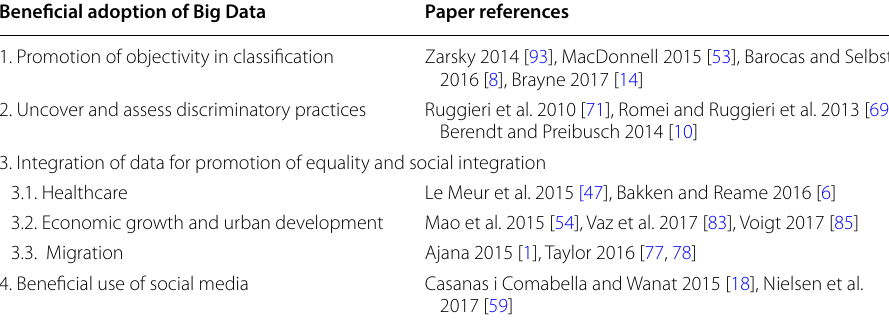
Table 7 Beneficial adoption of data analytics Beneficial adoption of Big